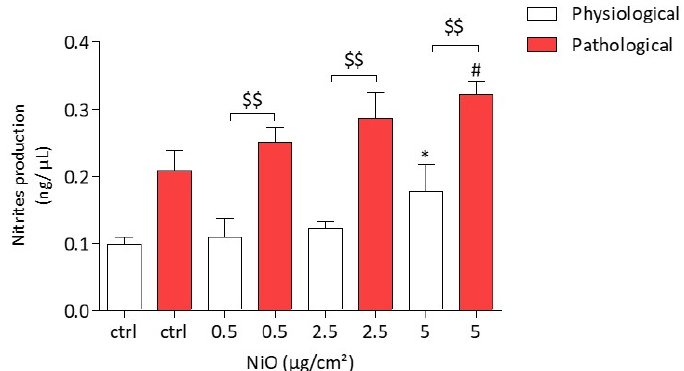
Figure 4. Nitrite production in HPAEC after a 24 h exposure to NiONPs (0.5–5 µ g/cm 2 ) under physio- logical and pathological conditions, measured by Griess reaction. The results were expressed as ng/ µ L in the supernatant. Data are mean ± SEM of five independents experiments ( n = 5) performed in quadruplicate. * p < 0.05 vs. untreated cells in 0% CS in normoxic conditions. # p < 0.05 vs. untreated cells in pathological conditions. $$ p < 0.01 between both conditions. According to Kruskal–Wallis test followed by a Dunn’s multiple comparison test.